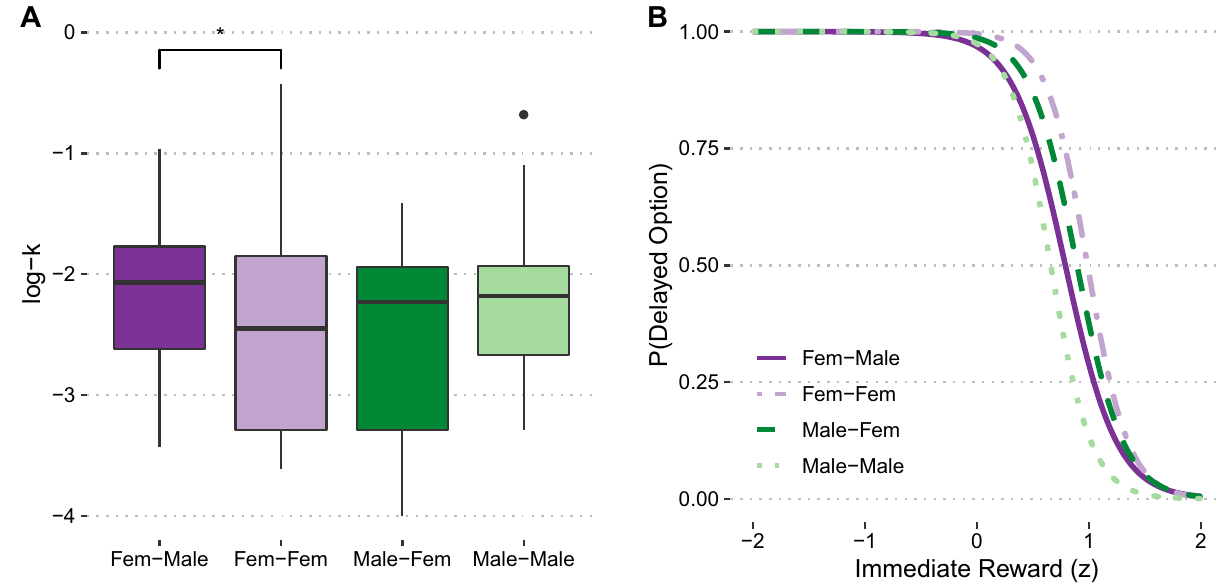
Figure 4. Intertemporal discounting task. ( A) Log-transformed estimated discount factors k delay (log-k) by Sex and Group, median and interquartile ranges are displayed. A larger k reflects more immediate choices with longer delay. ANOVA revealed a significant Sex × Group interaction, which was driven by female participants: they chose more smaller sooner rewards when they swapped into male bodies than into female bodies. ( B) The probability of choosing a delayed option is displayed as a function of the magnitude of the immediate reward. MGLM revealed a significant Group × Reward magnitude interaction: Participants in different-gender avatars were less sensitive to the magnitude of the immediate reward than same-gender avatars as indicated by the less steep logistic